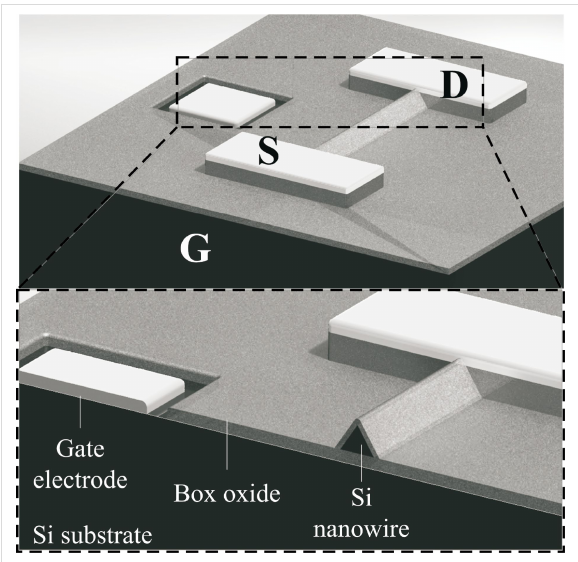
Figure 4: Schematic of the applied SiNW FET device.